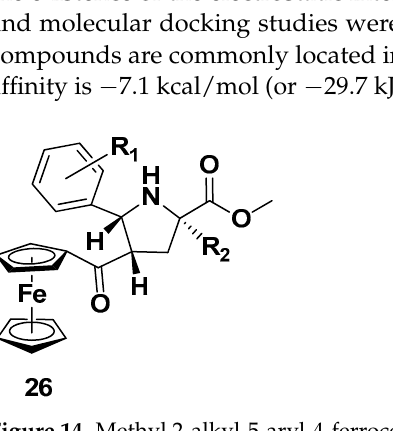
Figure 14. Methyl 2-alkyl-5-aryl-4-ferrocenoylpyrrolidine-2-carboxylates ( 26